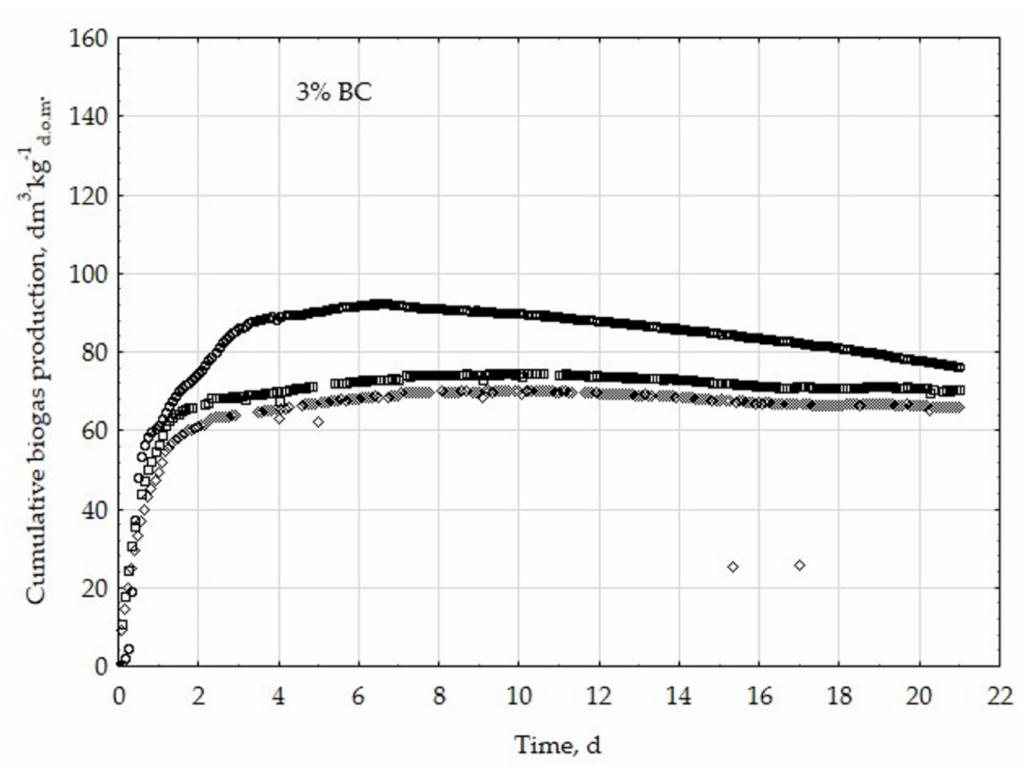
Figure A3. Biogas production from BSG: cumulative curves in variant with biochar addition at the level of 3%. The number of repetitions was three.